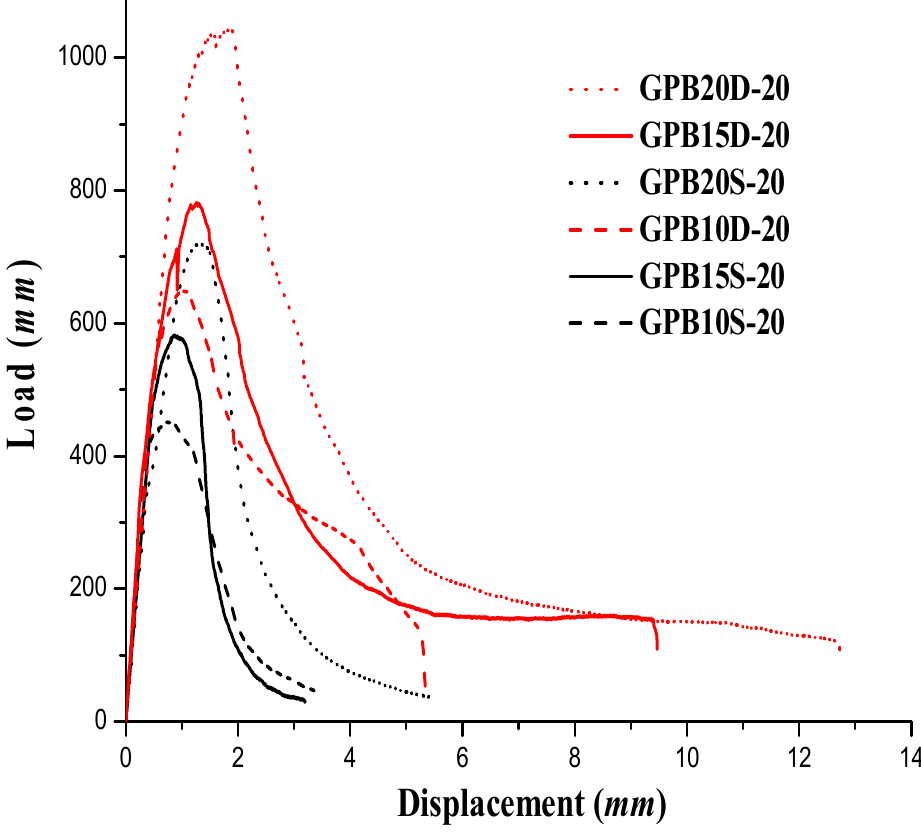
Figure 8. Load–displacement curves of the connection series at ambient temperature.